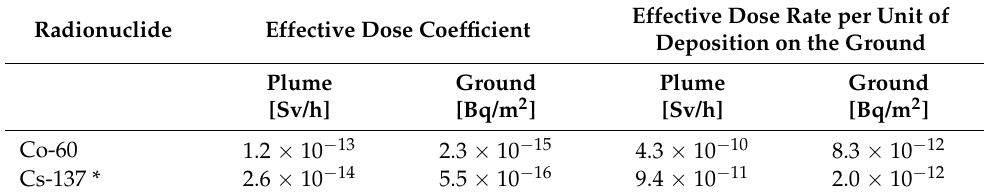
Table 2. Direct radiation from the plume and from the ground. Radionuclide Effective Dose Coefficient